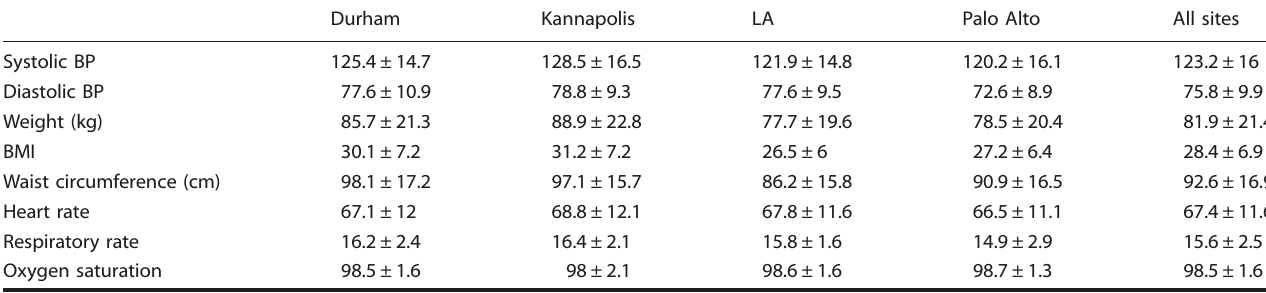
Table 3. Study vitals